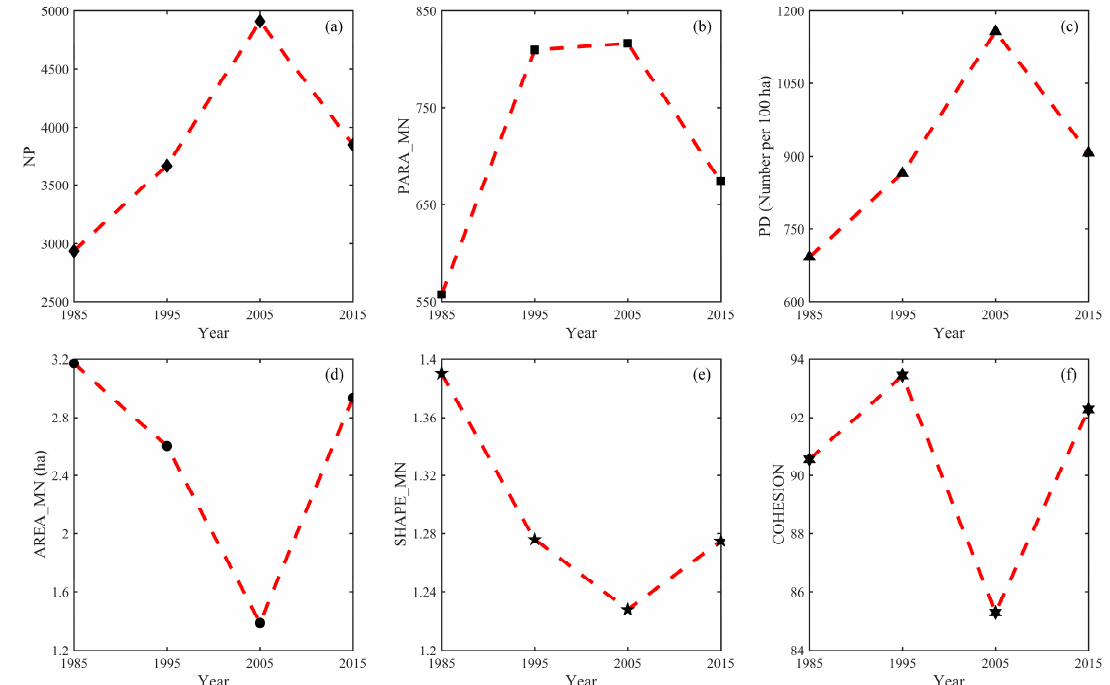
Figure 9. Class metrics of mangrove patches: ( a ) NP: Number of Patches, ( b ) PARA_MN: Mean Perimeter-Area Ratio, ( c ) PD: Patch Density, ( d ) AREA_MN: Mean Patch Area, ( e ) SHAPE_MN: Mean Shape Index and ( f ) COHESION: Patch Cohesion Index.